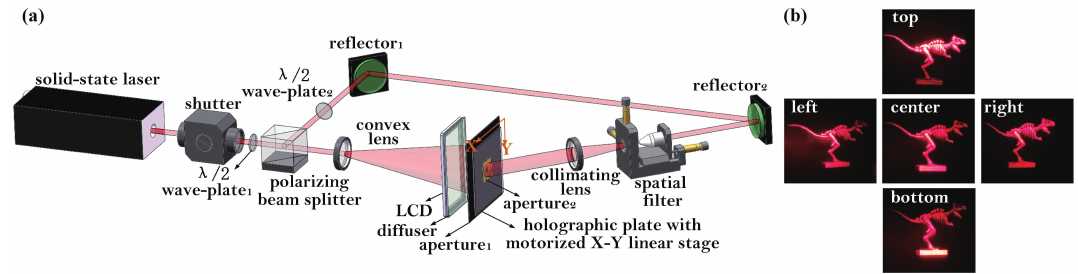
Figure 14. Optical setup of the holographic stereogram printing system ( a ) and images of optical reconstruction from different perspectives produced by our group ( b ). (Reprinted with permission from ref [38], [Springer